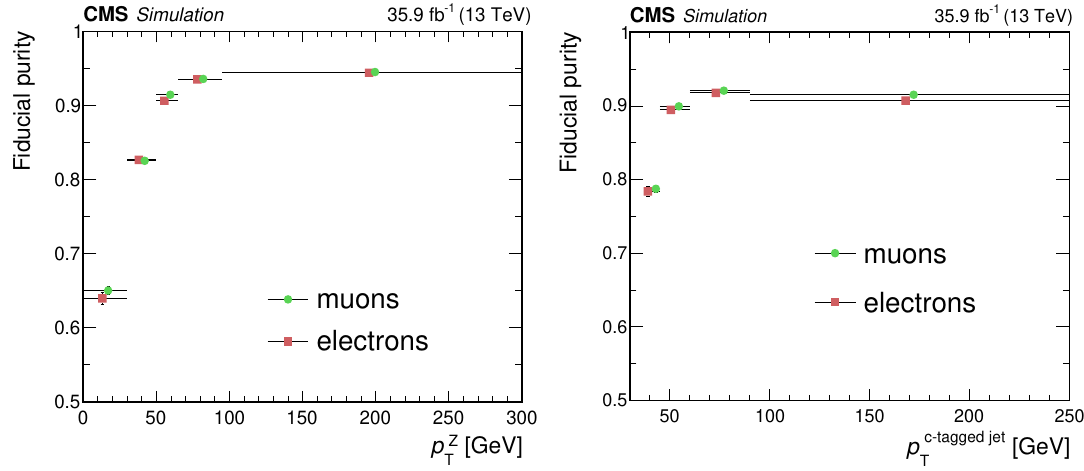
Figure 5 . Fraction of selected Z + c jet events originating within the fiducial phase space as a function of p . The plots show distributions for electron and muons channels as a function of p Z T (left) and p c -tagged jet (right). T